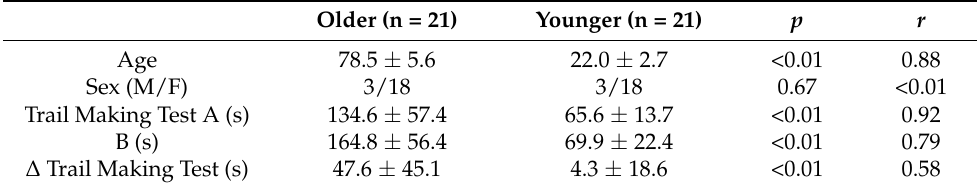
Table 1. Comparison between the older and younger adults.